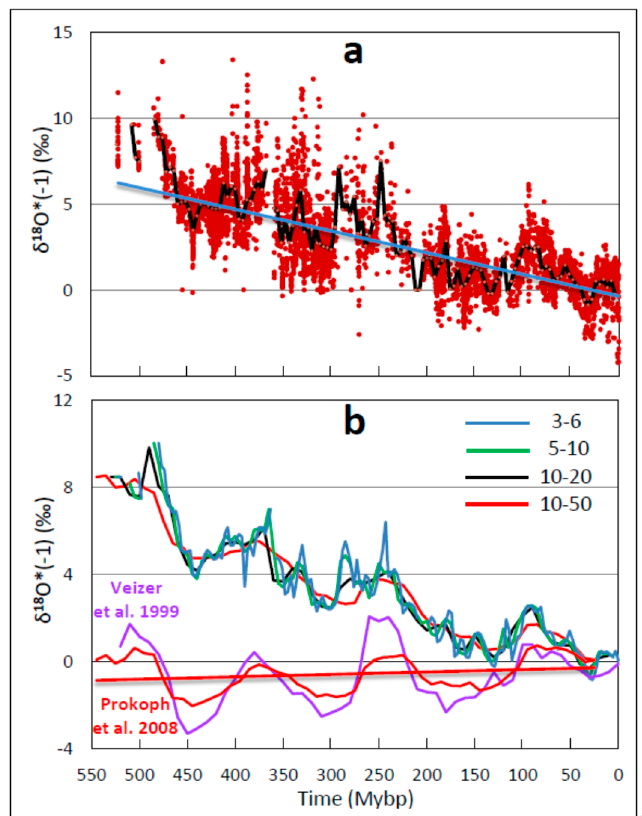
Figure 3. Temperature proxies over the Phanerozoic Eon. ( a ) Raw temperature data (red datapoints) and fitted black curve (3–6 My moving average). Original data are from Prokoph et al. [28]. ( b ) averaged non-detrended (upper curves) and linearly-detrended (lower curves) temperature proxy data. The curves of moving averages are color coded following the key in My. In ( b ), detrended older data from Veizer et al. [38] and inclusive newer and more comprehensive data from Prokoph et al. [28] are compared (lower curves).